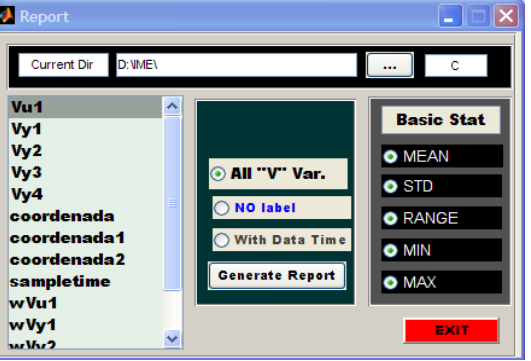
Figura 8. Interfaz para enlace de fichero Excel y selección de estadígrafos.